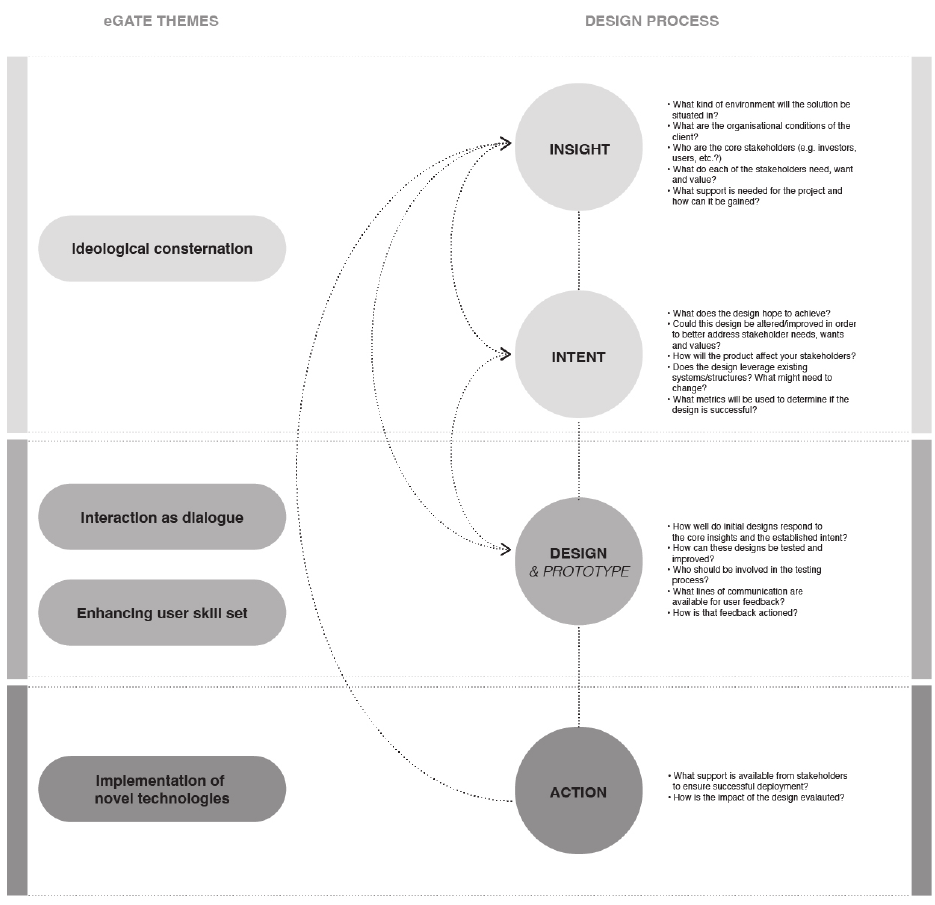
Figure 3. Alternative design process, inspired by the design innovation in health and medicine framework